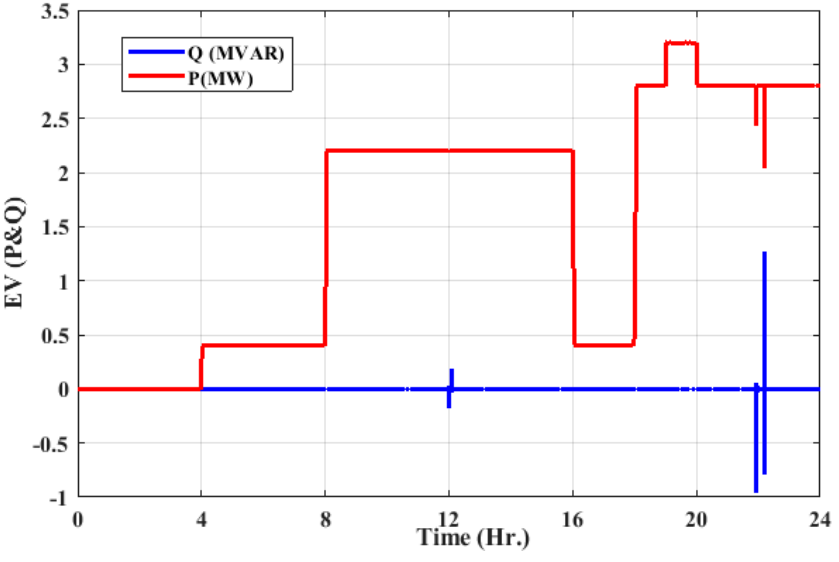
Figure 9. Active and reactive power of EVs.